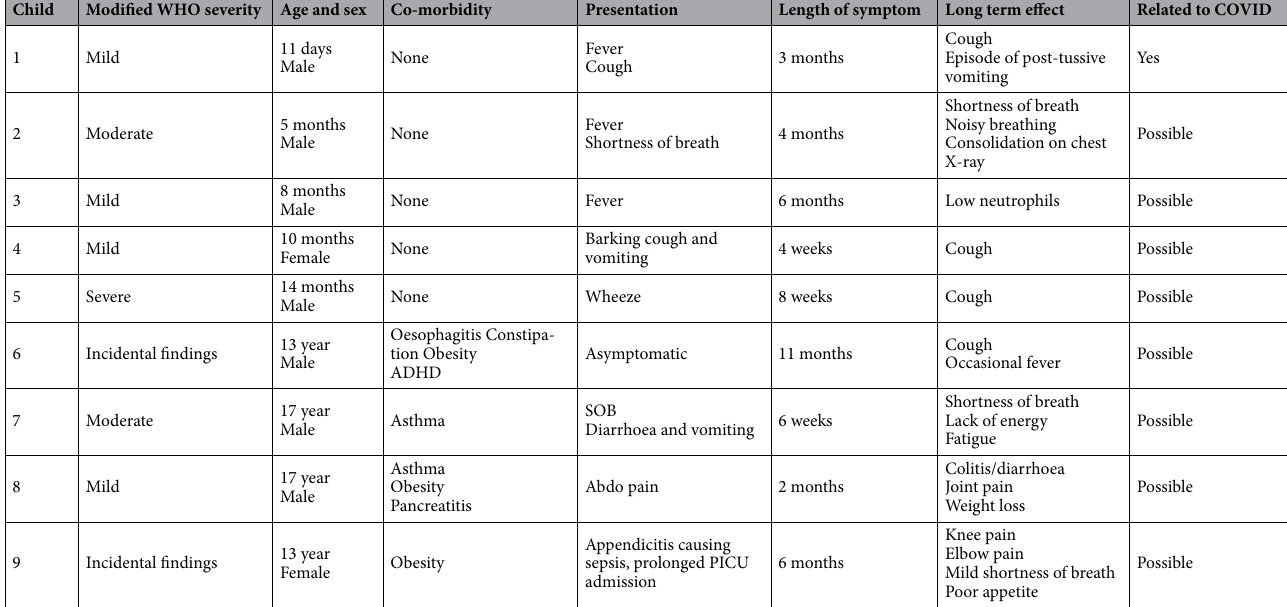
Table 1. Children and young people with symptoms beyond 4 weeks, which had resolved.